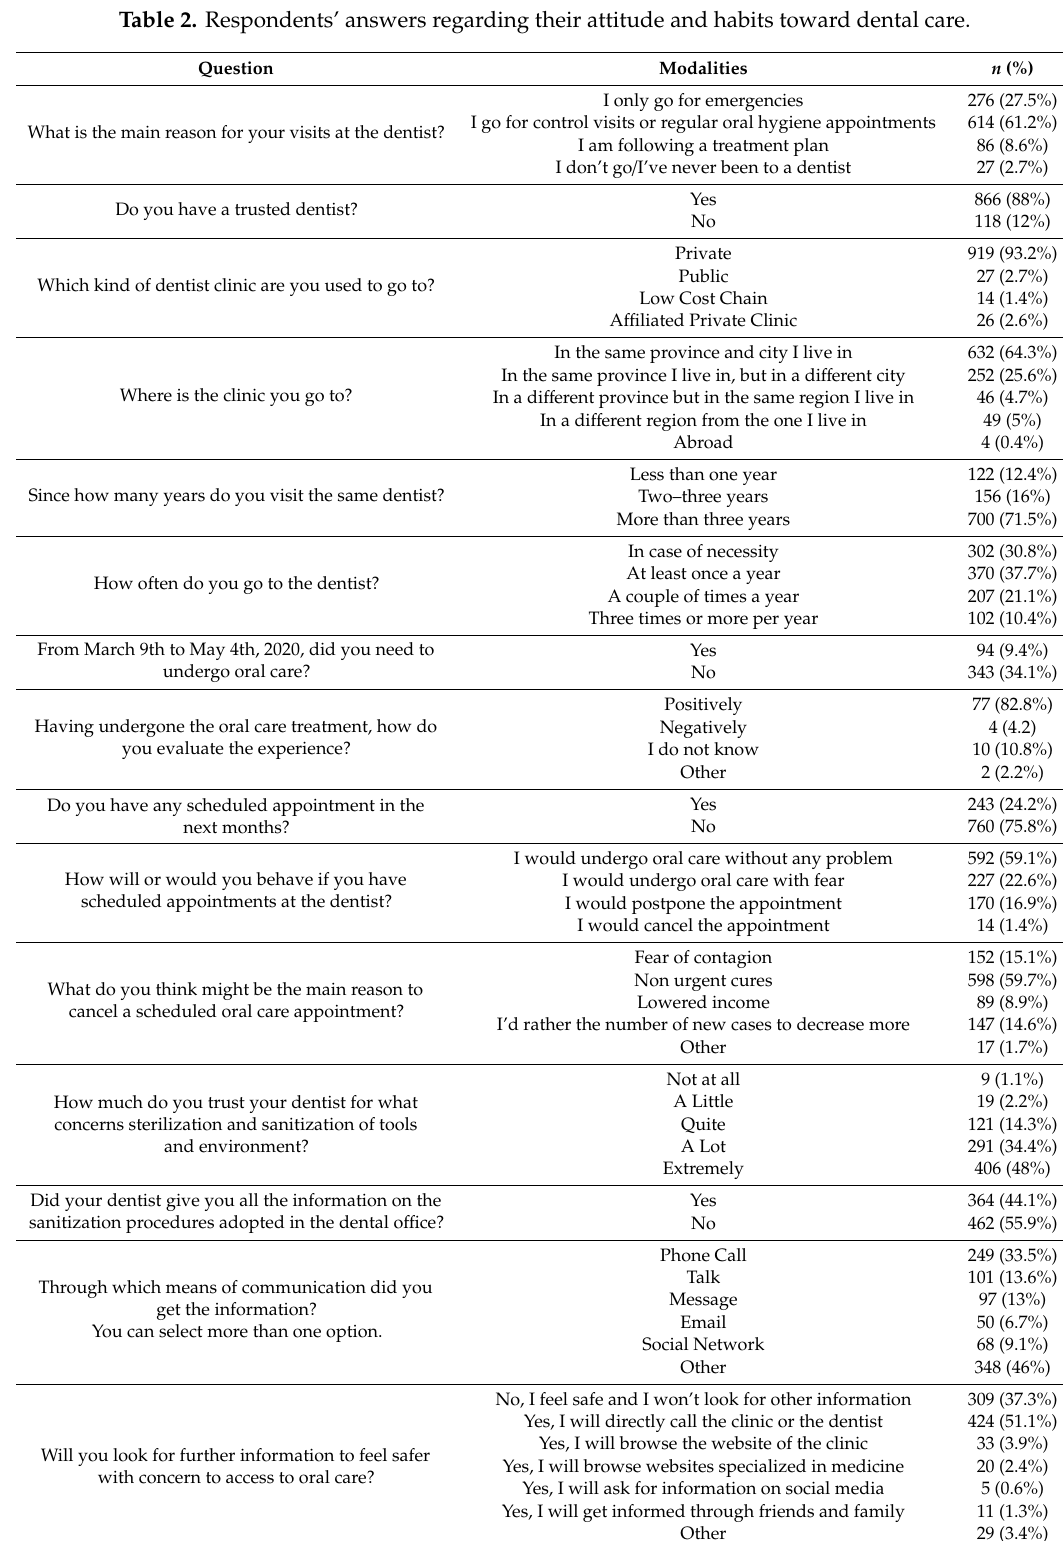
Table 2. Respondents’ answers regarding their attitude and habits toward dental